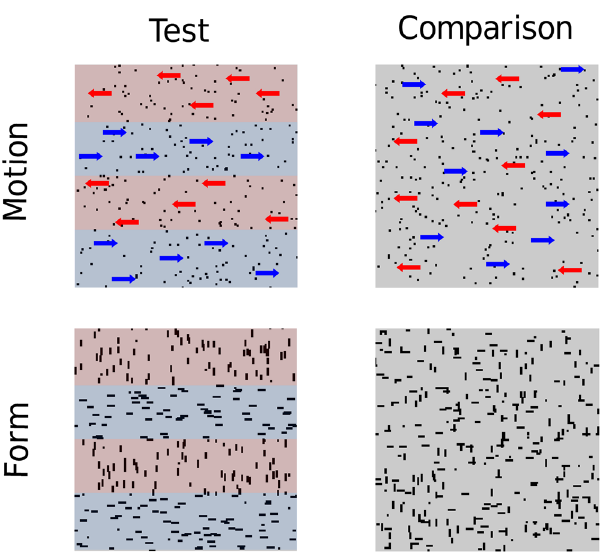
Figure 1. Schematic of the stimuli in the motion and form tasks. Coloured overlays and arrows have been added for illustrative purposes only and depict how the test stimuli were spatially